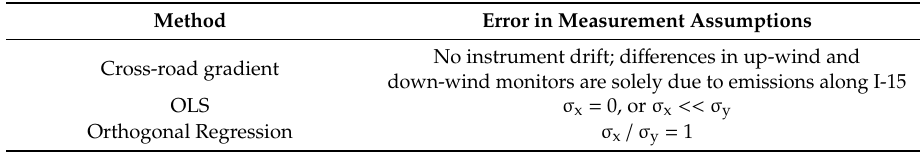
Table 1. Summary of underlying error variance assumptions of the methods considered in this analysis. σ x and σ y are the standard deviation of the error in measurements of CO and NO x ,